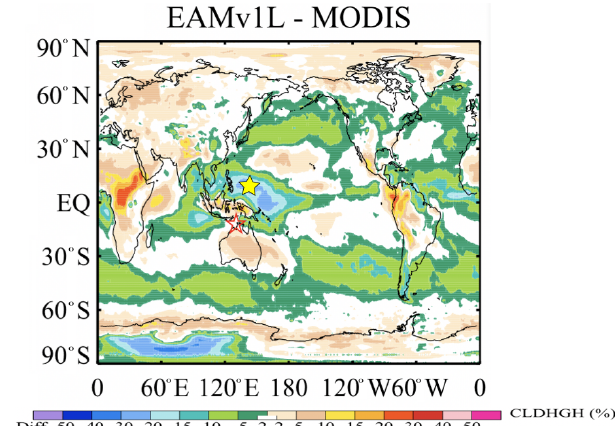
Figure 6. Climatological E3SMv1 high cloud bias, computed rela- tive to MODIS observations, from Xie et al. (2018). Open red star shows location of the TWP field campaign, while solid yellow star shows the location we use for our E3SM SCM replay